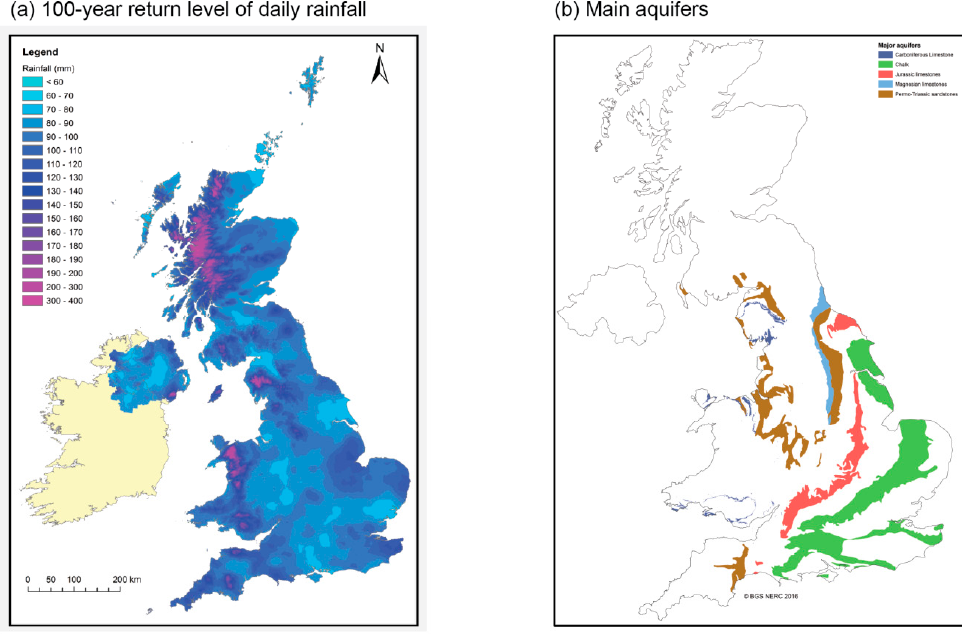
Figure 1. ( a ) The 100 ‐ year return level of observed 24 ‐ h rainfall across Great Britain [7], calculated using the FEH method [9] on observations; and ( b ) main aquifers of Great Britain (courtesy of